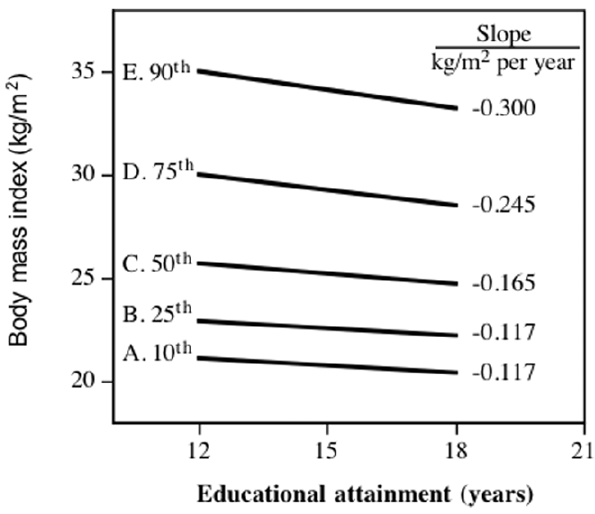
Figure 1. Regression lines comparing the calculated per kg/m 2 decrease in BMI per year of educational attainment in Study 1 females, where BMI is represented along the Y-axis and reported educational attainment is represented along the X- axis. Data adjusted for age, race, physical activity, parental adiposity, and diet. Individual slopes significantly different from zero at p , 10 2 6 .